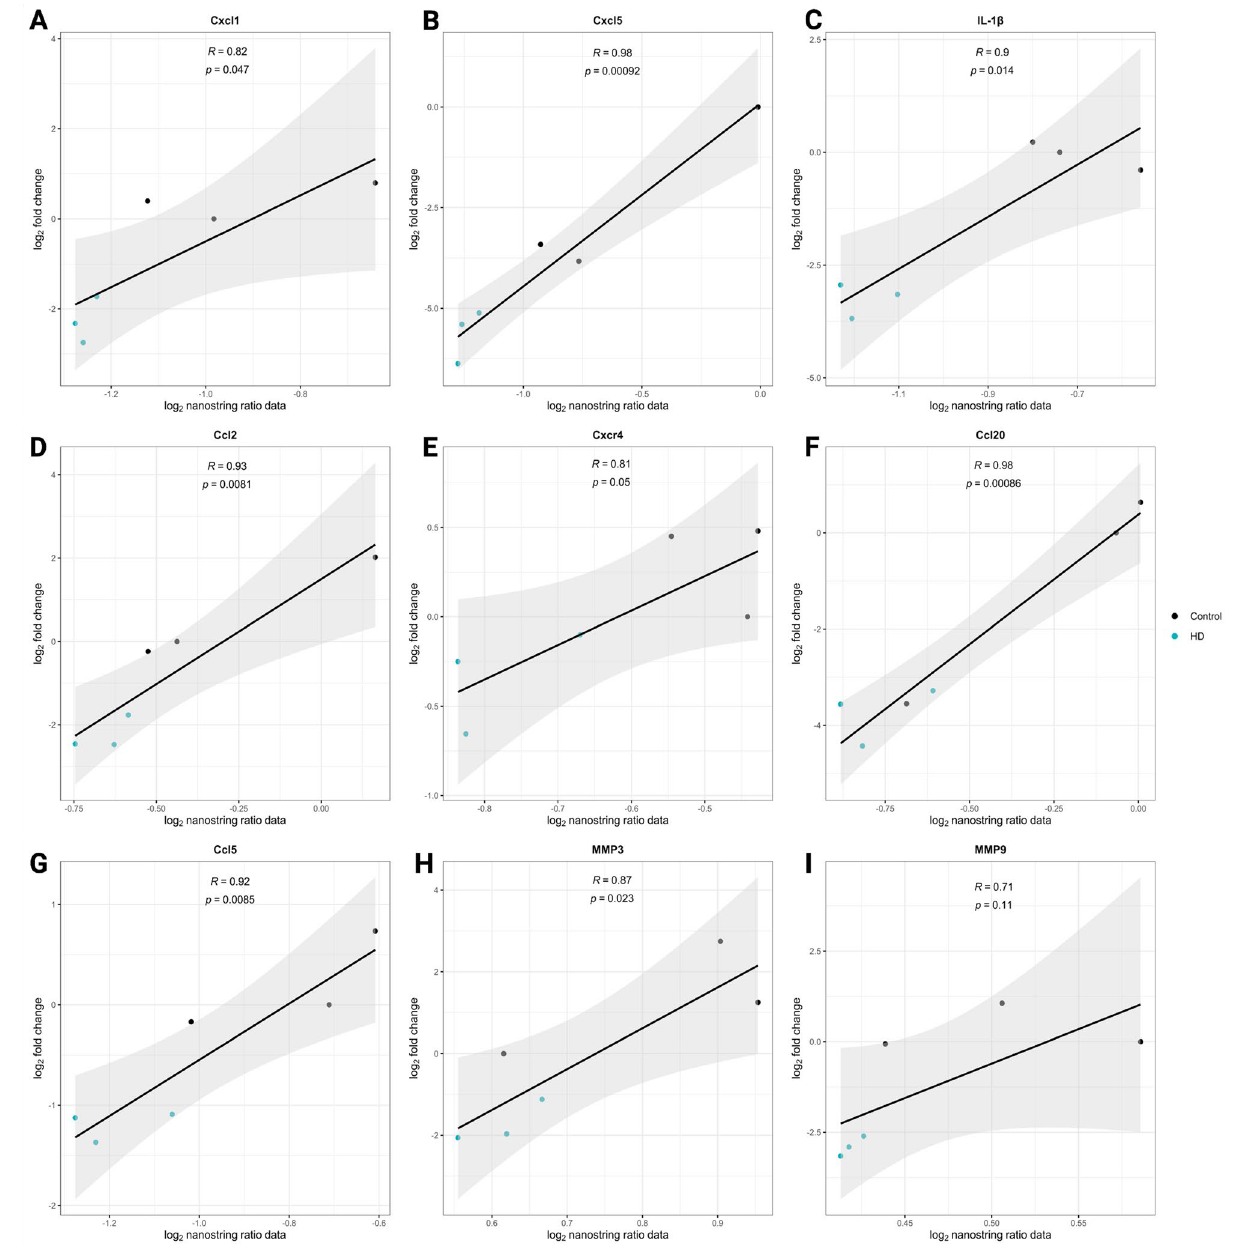
Figure 3. Inter-platform correlation between NanoString and qPCR assays. Log 2 fold change from real-time PCR (qPCR) analysis was subjected to pairwise Pearson correlation against log 2 fold changes obtained from NanoString analysis for key downregulated hub genes including, Cxcl1 ( A ), Cxcl5 ( B ), IL-1β ( C ), Ccl2 ( D ), Cxcr4 ( E ), Ccl20 ( F ), Ccl5 ( G ), MMP3 ( H ), and MMP9 ( I ). High to very high positive correlation between their NanoString and qPCR mRNA expression levels was observed for all these hub genes. Pearson correlation coefficient ‘R’ values ranged from 0.71 to 0.98 for all